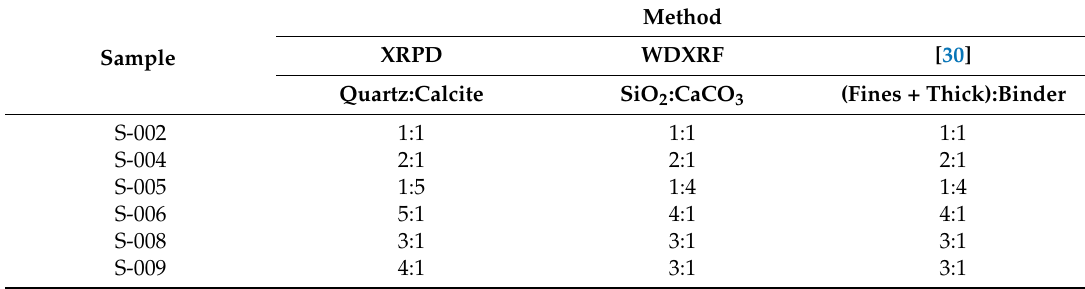
Table 5. Comparison of different methods for the reconstitution of mortars.